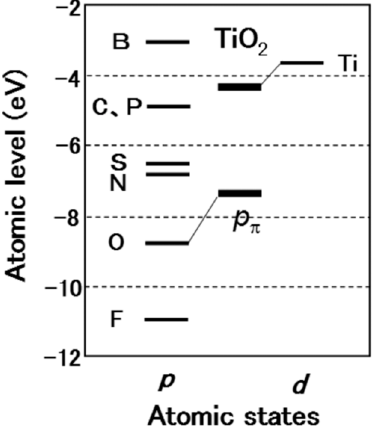
Figure 6. Comparison of atomic p levels among anions. The band gap of TiO 2 is formed between the O 2p π and Ti 3d states [39]. Copyright 2014 American Chemical Society.